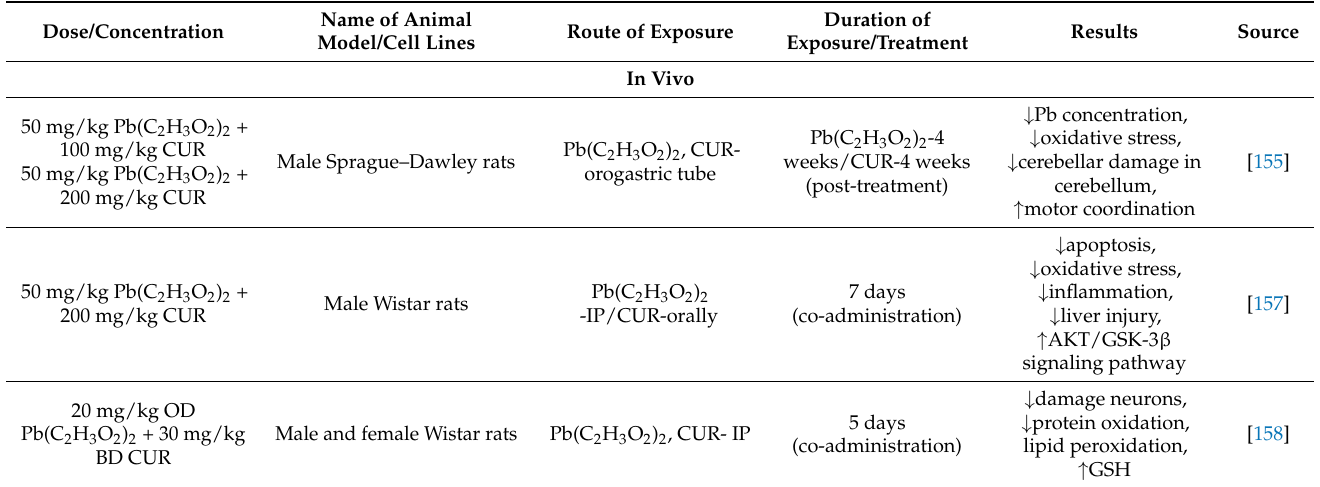
Dose/Concentration